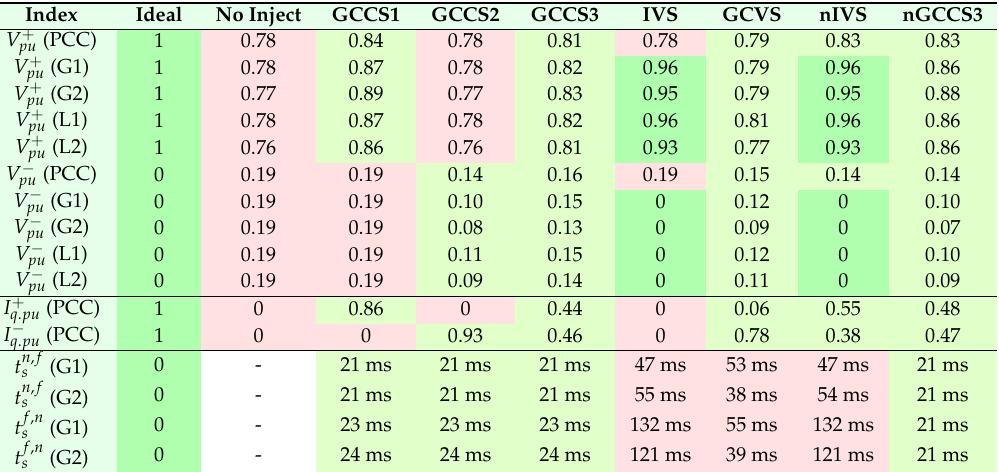
Table 4. Quality indexes measured for type I voltage